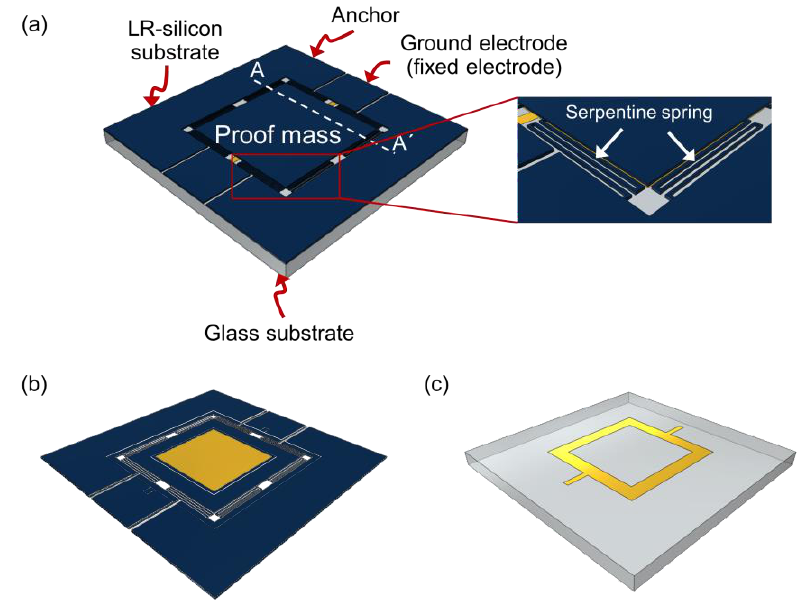
Figure 2. ( a ) Schematic diagram of vertical MEMS actuator based on Otto configuration, ( b ) silicon substrate viewed from the side for anodic bonding, ( c ) glass substrate viewed from the side for anodic bonding.